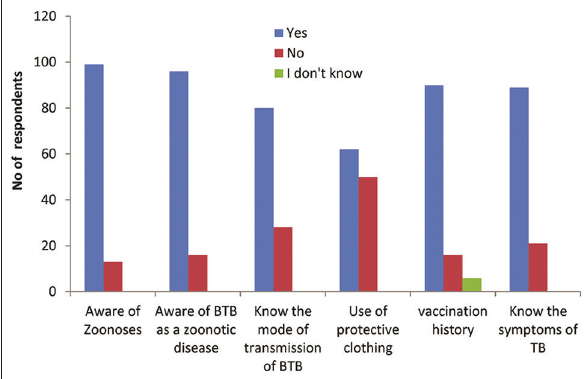
Figure-2: Level of respondents’ (abattoir staff) awareness of bovine tuberculosis as a zoonotic disease, in Gombe Township Abattoir, Gombe State,